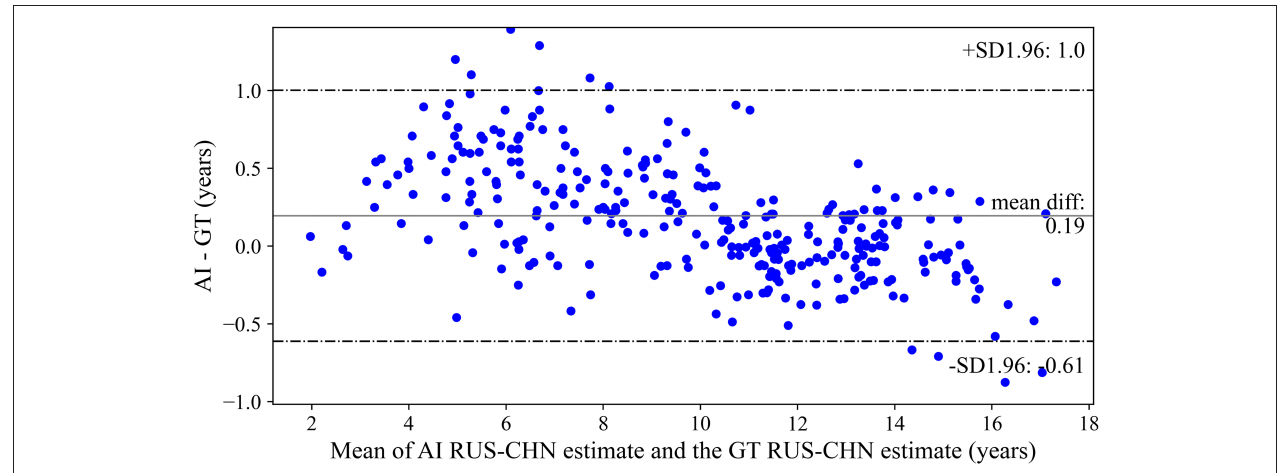
FIGURE 2 | Bland-Altman plot of differences between the artificial intelligence model and reference standard bone age assessments. AI, artificial intelligence; RS, reference standard; RUS-CHN, Chinese Standard of Skeletal Maturity of the Hand and Wrist.